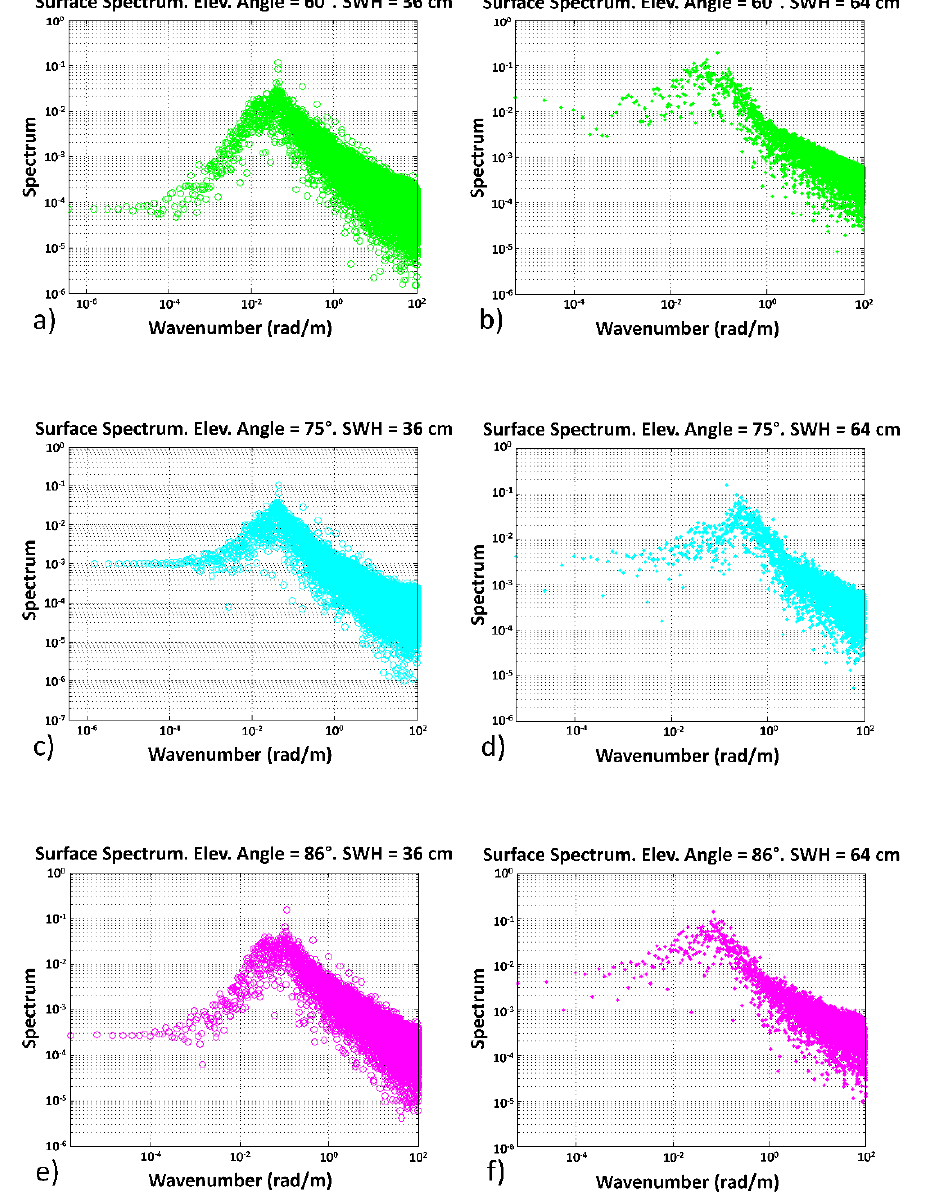
Figure 11. For an elevation angle of ( a , b ) θ water surface spectra as measured by PYCARO using the GPS C/A code for SWH = 36 cm and (b,d,f) for SWH = 64